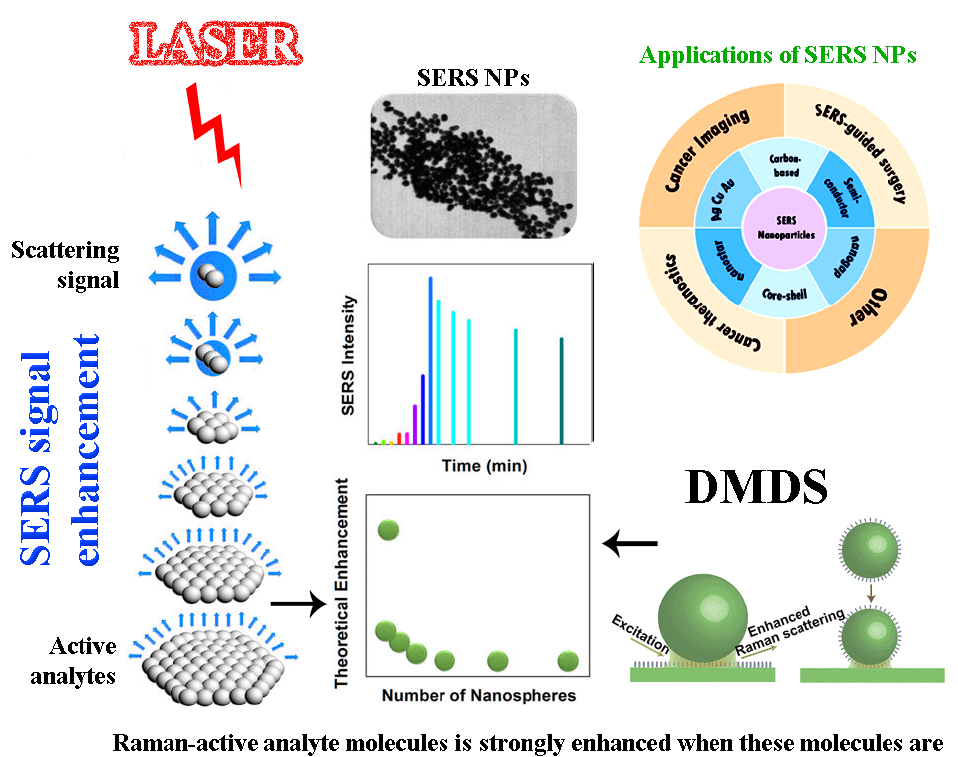
Figure 1. Applications of SERS for pathogenic detection and disease diagnosis.